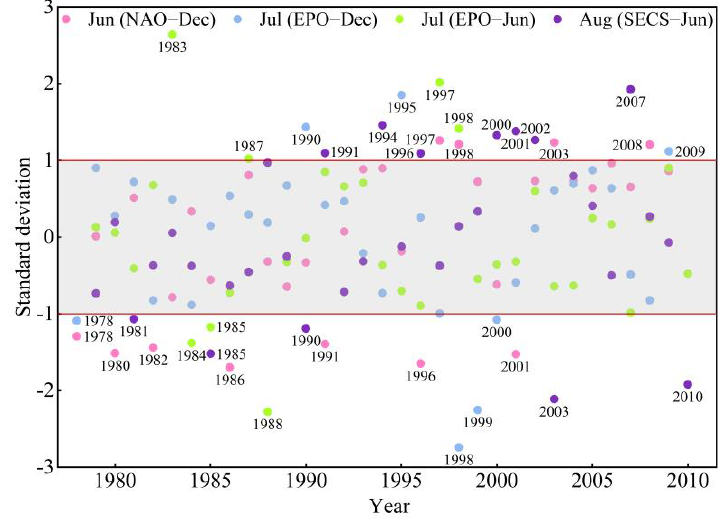
Figure 6. Years with high and low SST anomalies.